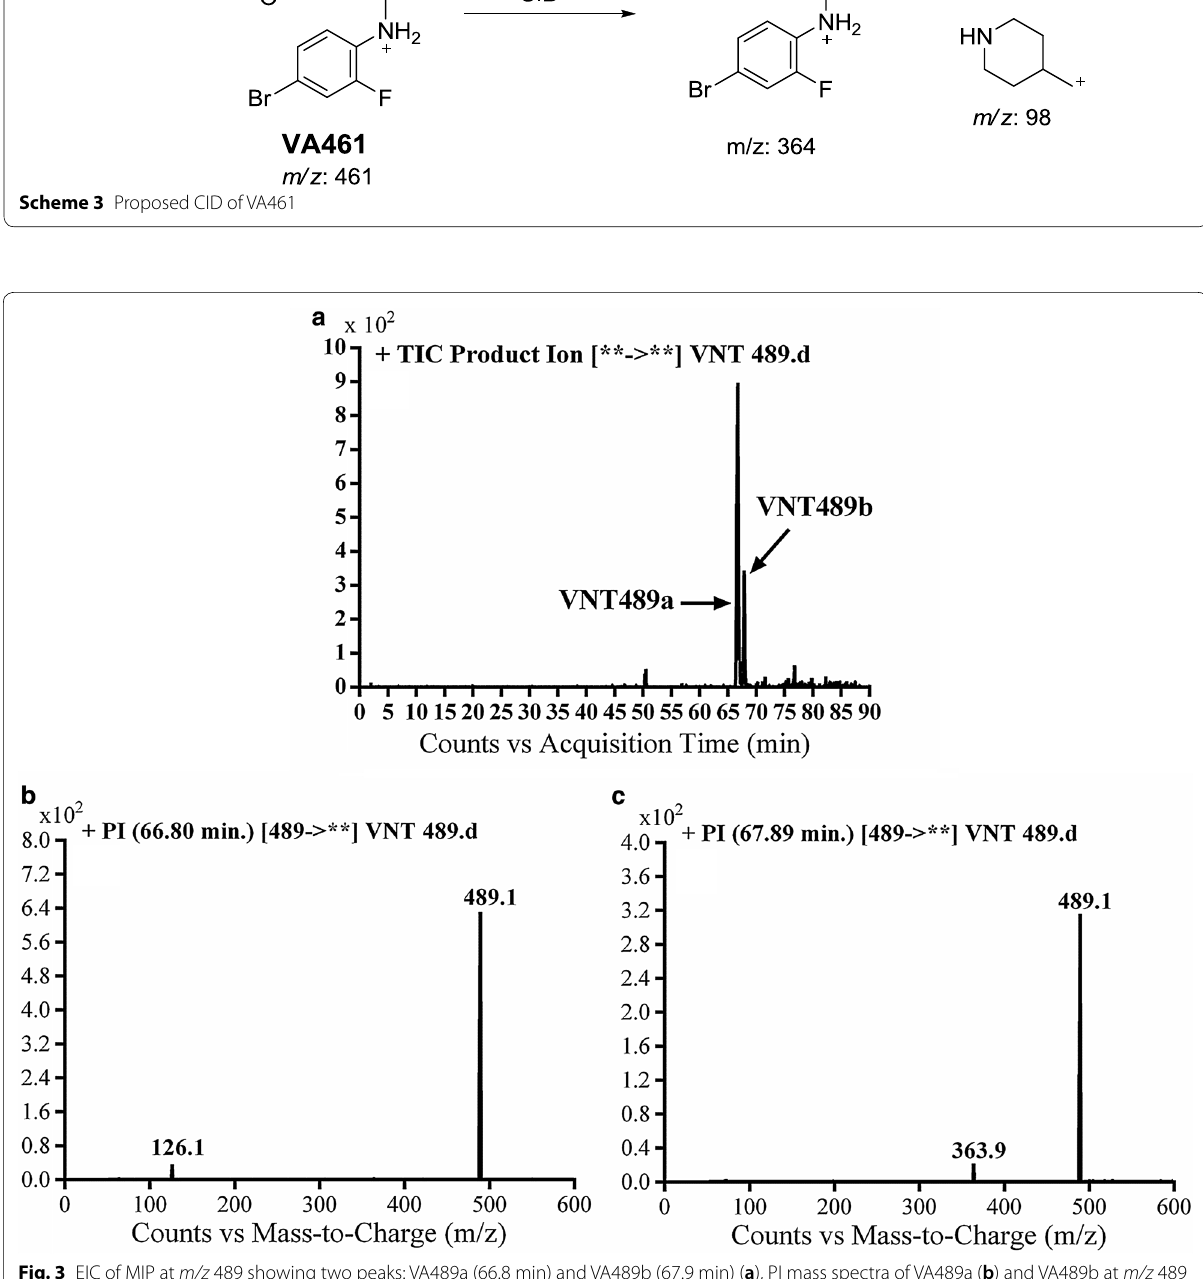
Fig. 3 EIC of MIP at m/z 489 showing two peaks: VA489a (66.8 min) and VA489b (67.9 min) ( a ), PI mass spectra of VA489a ( b ) and VA489b at m/z 489 ( c